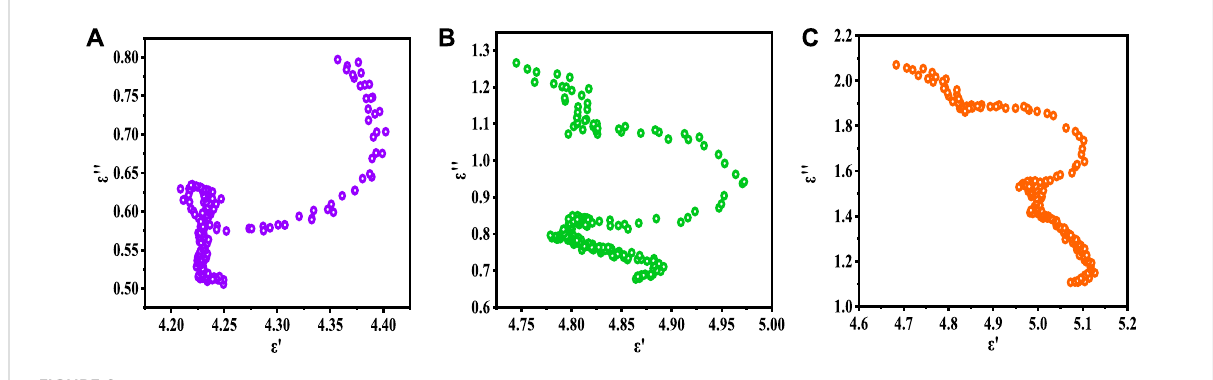
FIGURE 9 Cole-Cole semicircles of Fe 3 O 4 /AC nanocompositesin three different percentages of carbon (A) AC-25%, (B) AC-50%, and (C) AC-75%.